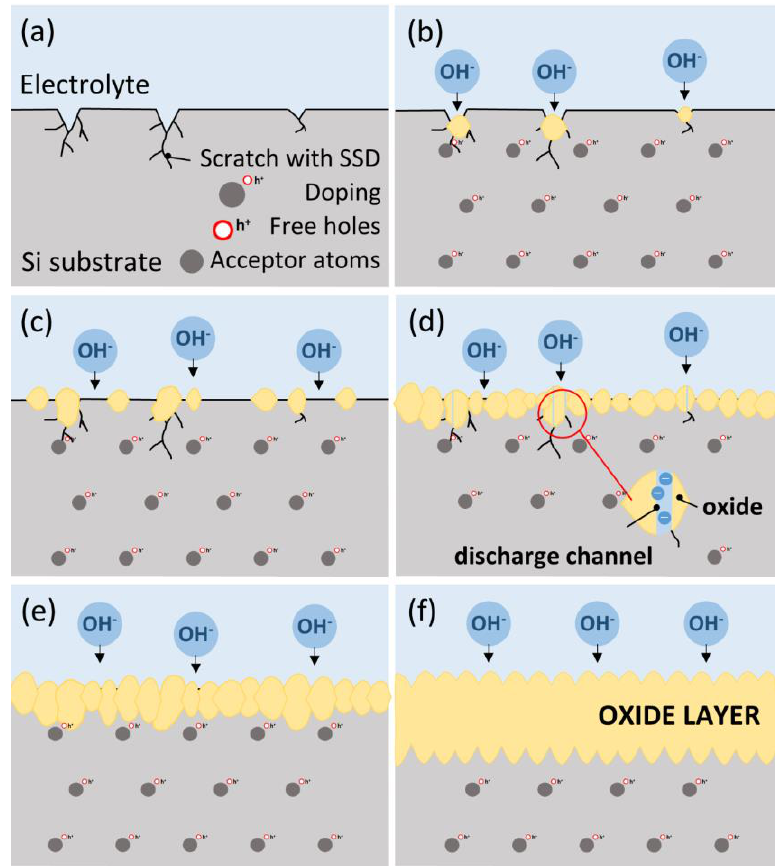
Figure 9. The hypothesis of the electrochemical oxidation mechanism under potentiostatic mode. ( a ) schematic diagram of the electrochemical oxidation cross-section; ( b ) oxide protrusions first build up in the damaged area; ( c ) the extension of oxidation process; ( d ) pores formation between the oxide bottom and the substrate; ( e ) oxidation on the whole surface; ( f ) oxidation progresses to the end.